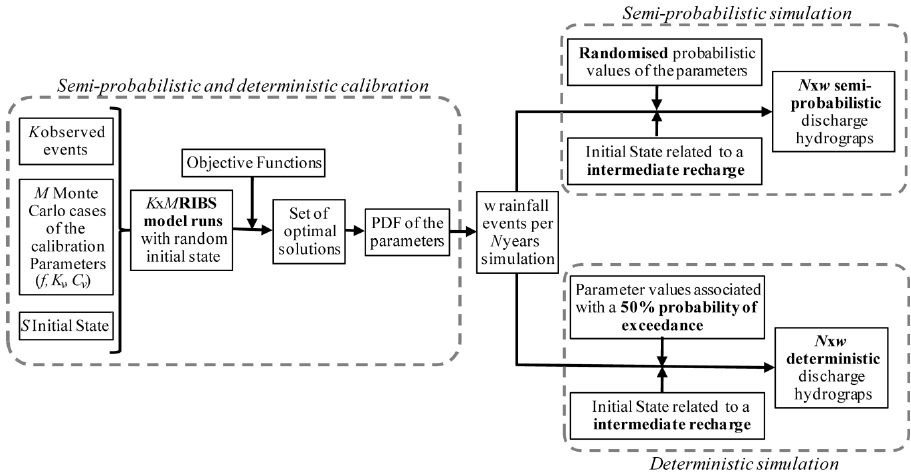
Figure 5. Semi-probabilistic and deterministic calibration–simulation process.